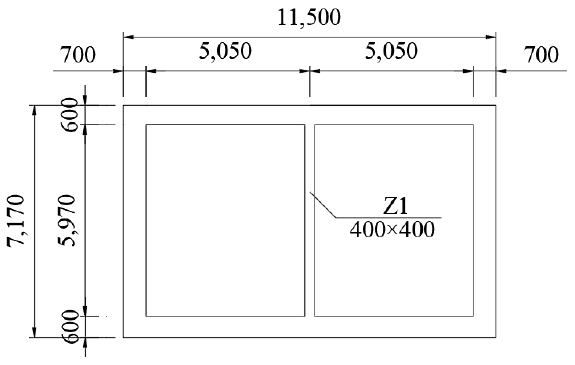
Figure 3. Section of the subway station (units in mm).